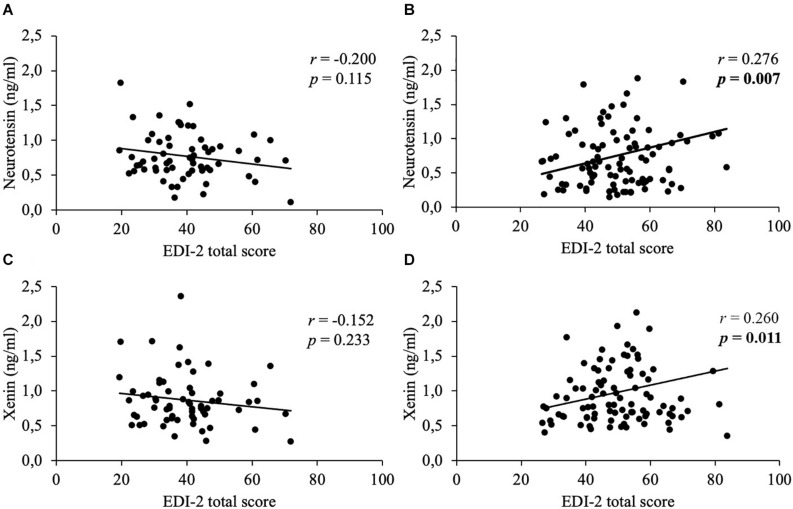
Correlations between neurotensin and xenin with EDI-2 total scores in men and women. Overall, in women neurotensin (B) and xenin (D) showed a positive correlation with EDI-2 total score, while for men no significant correlations with EDI-2 total score were detected, neither for neurotensin (A) nor for xenin (C). Correlations were calculated using Pearson’s analysis. EDI-2, Eating Disorder Inventory-2.